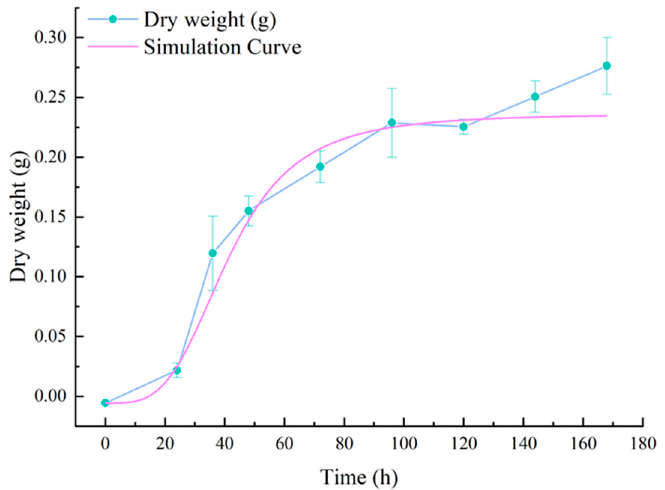
Figure 3. Growth curves of XK10.